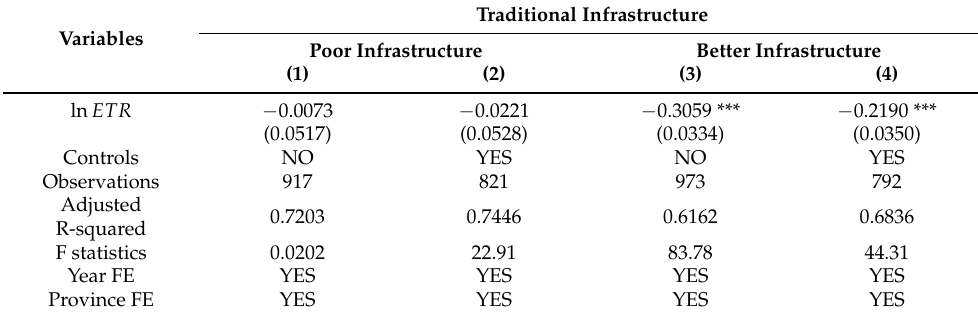
Table 5. Heterogeneity analysis: infrastructure.